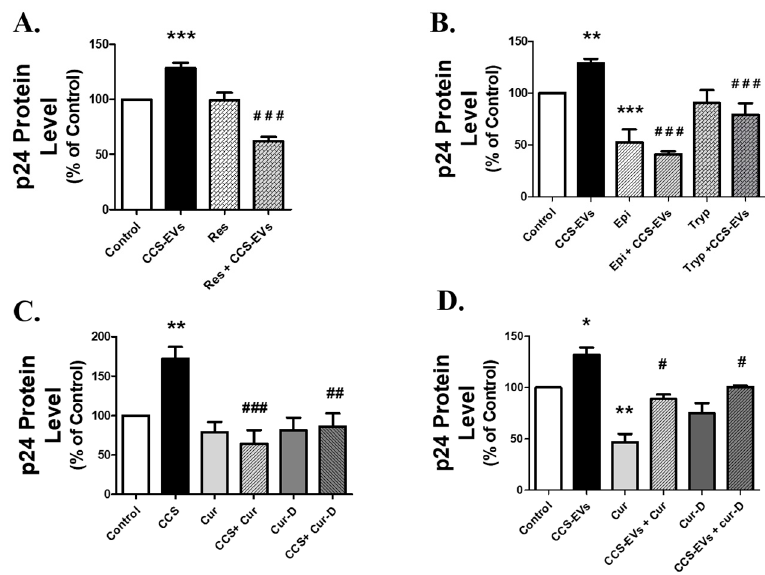
Figure7. Treatmentofantioxidant, CYPinhibitors, andchemodietaryagentsreduceCCSorCCS-derived Figure 7. Treatment of antioxidant, CYP inhibitors, and chemodietary agents reduce CCS or CCS- EVs (CCS-EVs)-induced HIV-1 replication in di ff erentiated U1 cell line. To confirm the role of derived EVs (CCS-EVs)-induced HIV-1 replication in differentiated U1 cell line. To confirm the role CYP-induced oxidative stress in CCS-EVs treated U1 cells, we treated di ff erentiated U1 cell line with the antioxidant, resveratrol ( A . Res, 25 µ M), CYP1A1 inhibitor, ellipticine ( B . Epi 1 µ M), and CYP2A6 inhibitor, tryptamine ( B . Tryp, 20 µ M). We also treated the U1 cells exposed to CCS ( C ) or CCS-EVs ( D ) with curcumin (cur, 20 µ M) and cucurbitacin-D (Cur-D, 0.1 µ M). All the data were obtained from the mean of at least three independent experiments with the error bars representing the standard error of mean. Significant di ff erences *, **, *** represent p < 0.05, p < 0.005, and p < 0.0005, respectively, when compared to the control. #, ##, ### represent p < 0.05, p < 0.005, and p < 0.0005, respectively, when compared to CCS or CCS-EVs